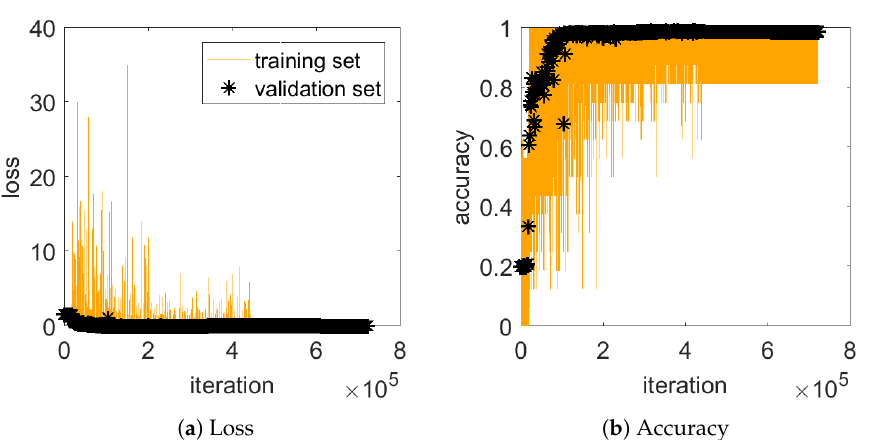
Figure 2. Evolution of training and validation losses ( a ) and of training and validation accuracies ( b ).